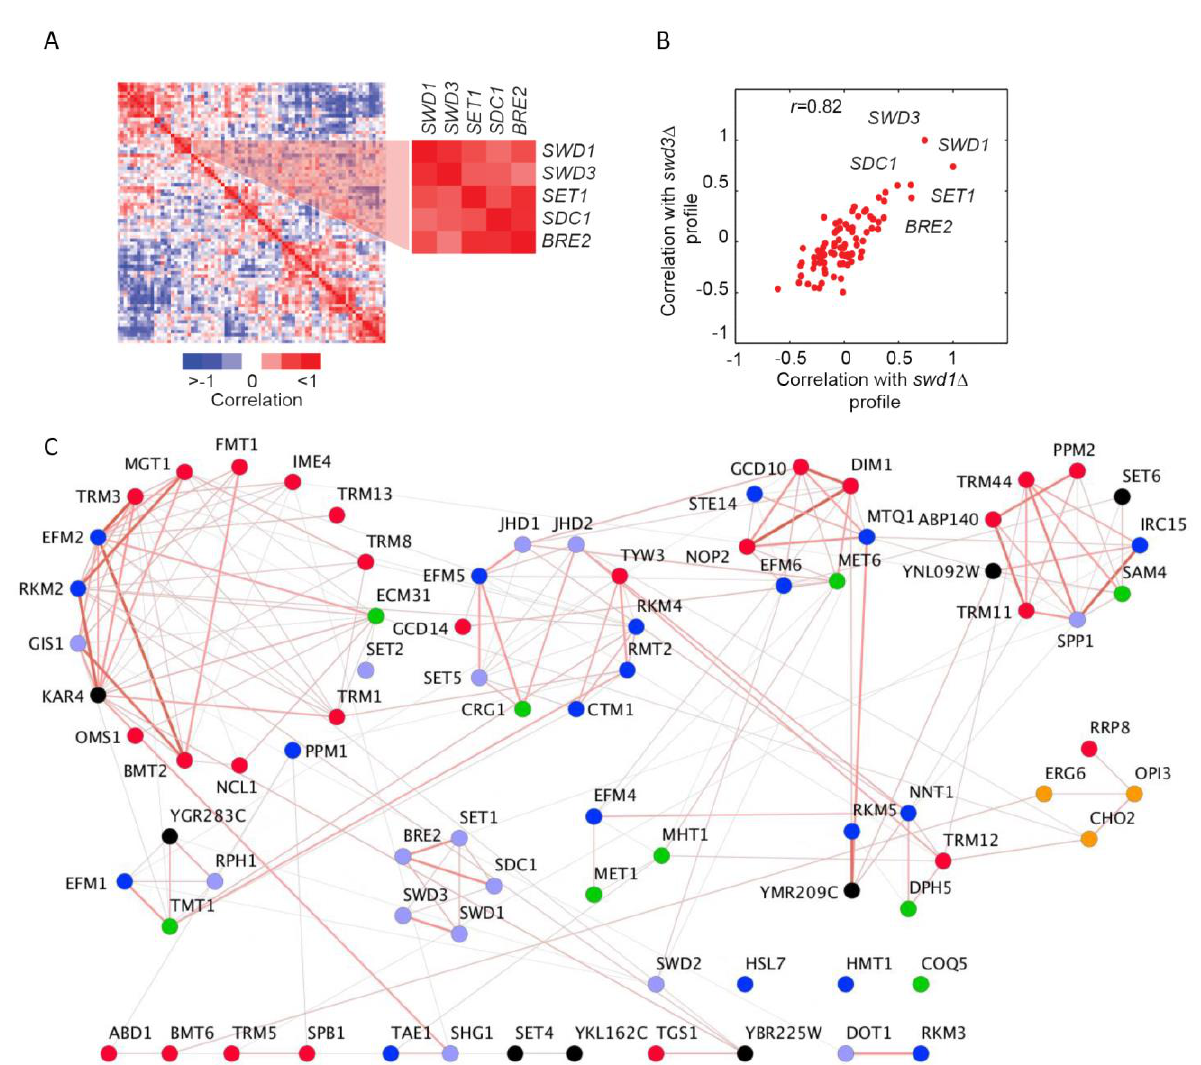
FIGURE 3: Genetic architecture of the yeast methyltransferome. (A) Correlation-based hierarchical cluster analysis. Each row/column represents a genetic interaction profile for a specific MT. A subset of positive score interactions among the components of COMPASS com- plex is shown. Strong positive and negative correlations among MTs are indicated by red and blue colors, respectively. (B) Scatter plot of the correlation coefficients of swd1 Δ and swd3 Δ with their genetic profiles. The most similar profiles for components of COMPASS complex are labeled. (C) Correlation-based clusters of similar MT profiles (r > 0.5). Nodes are individual MTs, and edges are correlation coefficient- based interactions between two nodes. Nodes are colored according to a substrate type (red, tRNA; blue, protein; purple, histone, green, small molecule; black, unknown). Edge width and color (red > 0.5, grey < 0.5) represent the magnitude of